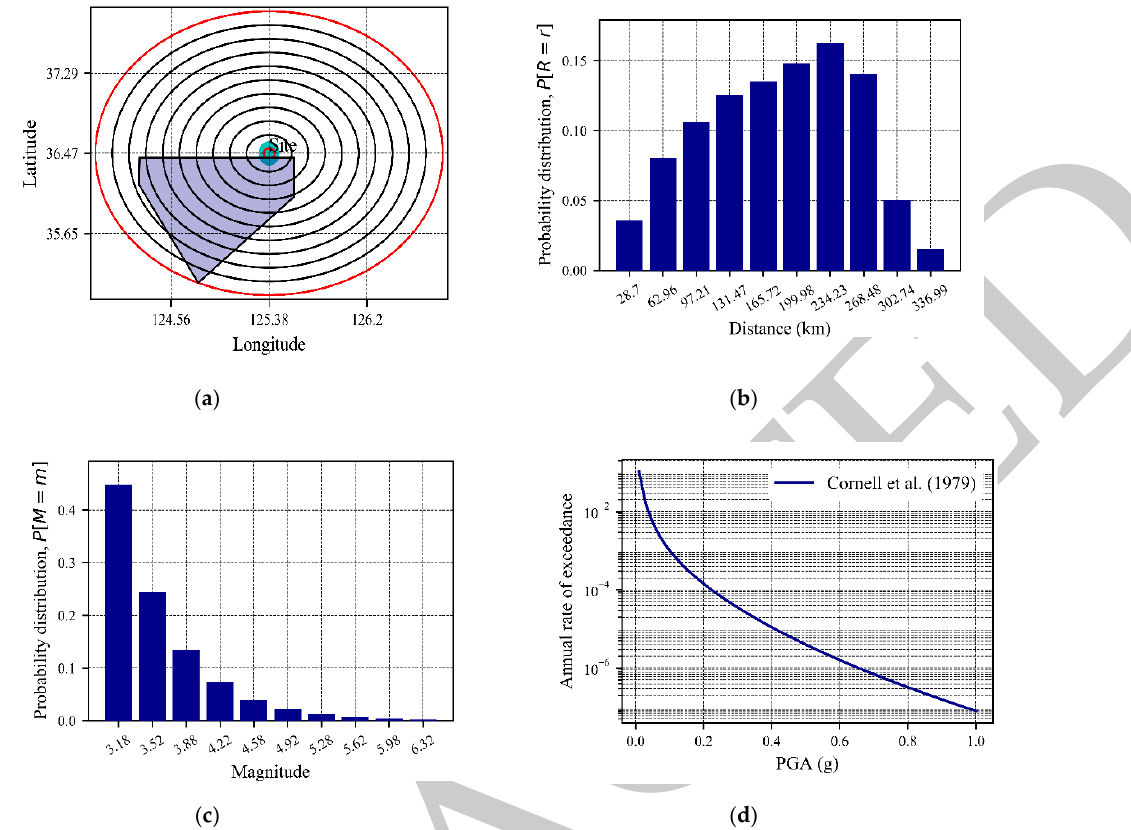
Figure 18. ( a ) Segmental view of area source, ( b ) Probability density function of distance, ( c ) Illustration of probability density function for magnitude for a source with a truncated Gutenberg–Richter distribution, ( d ) Probabilistic seismic hazard curve, respectively for RS2.